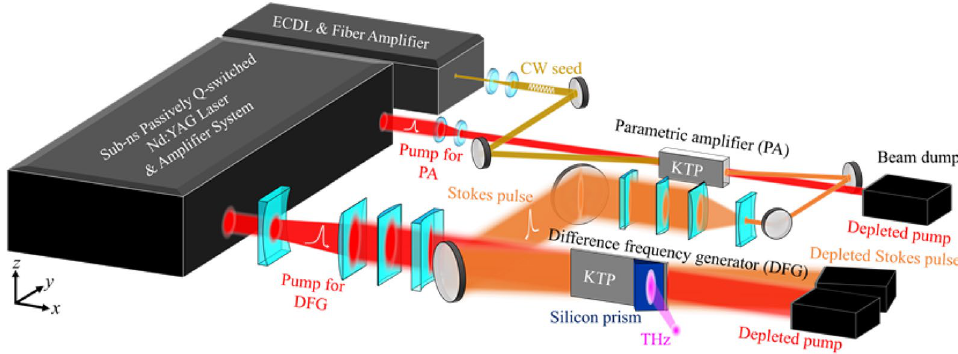
Figure 6. The schematic of the two-stage parametric source for demonstrating the high-resolution THz imaging. The first stage is a KTP PA seeded by a tunable diode laser, generating a high-power Stokes pulse. The second stage is a DFG for the pump and Stokes pulses, producing a high-power THz pulse via SPS in the second KTP crystal.